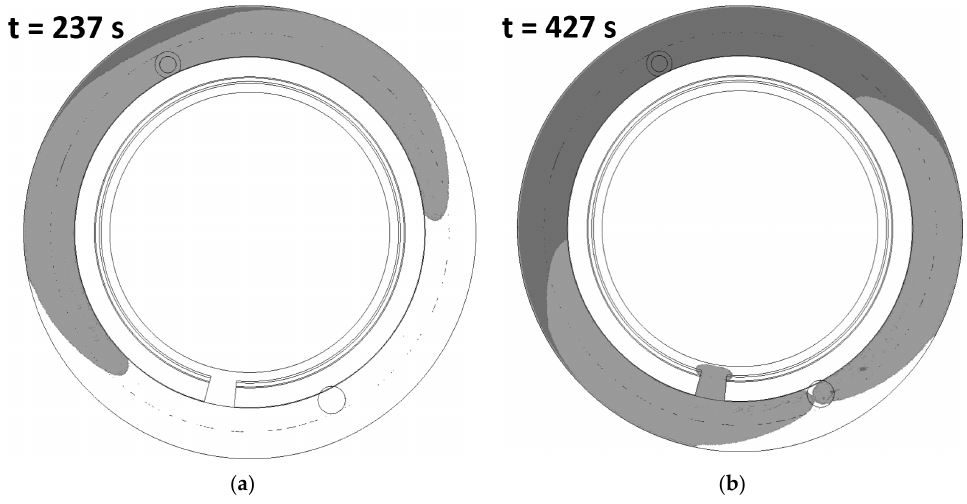
Figure 17. CFD images of the fi lling process for the “Bo tt om” case. ( a ) CFD result image at half time of the fi lling process; ( b ) CFD result image at touching time of the fi lling